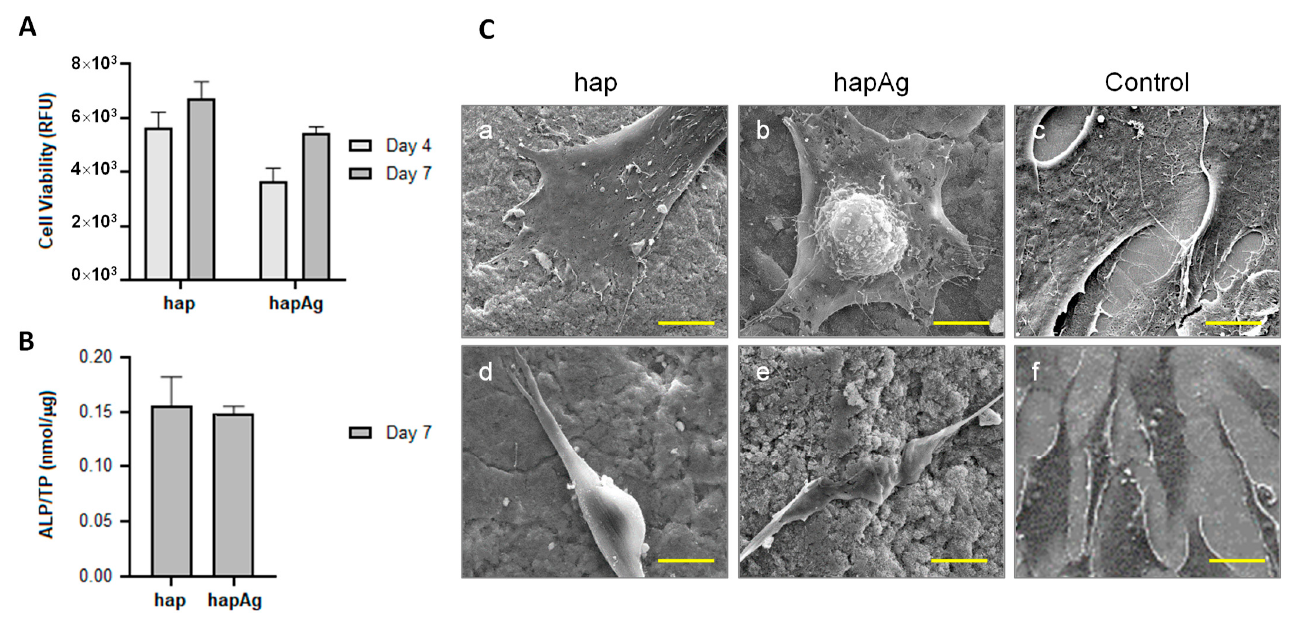
Figure 9. Behavior of MG63 osteoblastic cells cultured over hapAg pellets. Viable cell count (( A ); days 4 and 7), alkaline phosphatase activity (( B ); day 7) and SEM observation (( C ); day 4). Control (standard tissue culture plate). Bar = 5 μ m ( a – c ), 10 μ m ( d ), 2 μ m ( e ) and 20 μ m ( f ).